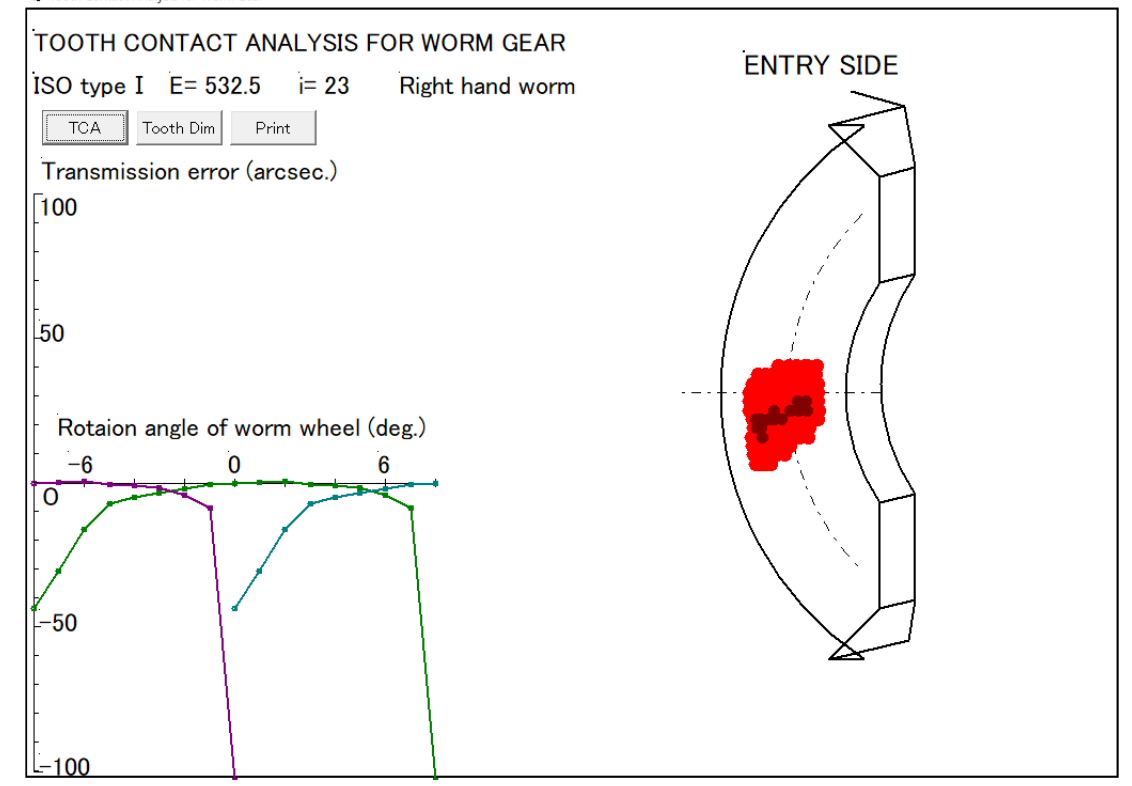
Figure 4. Analytical tooth contact pattern and transmission errors.